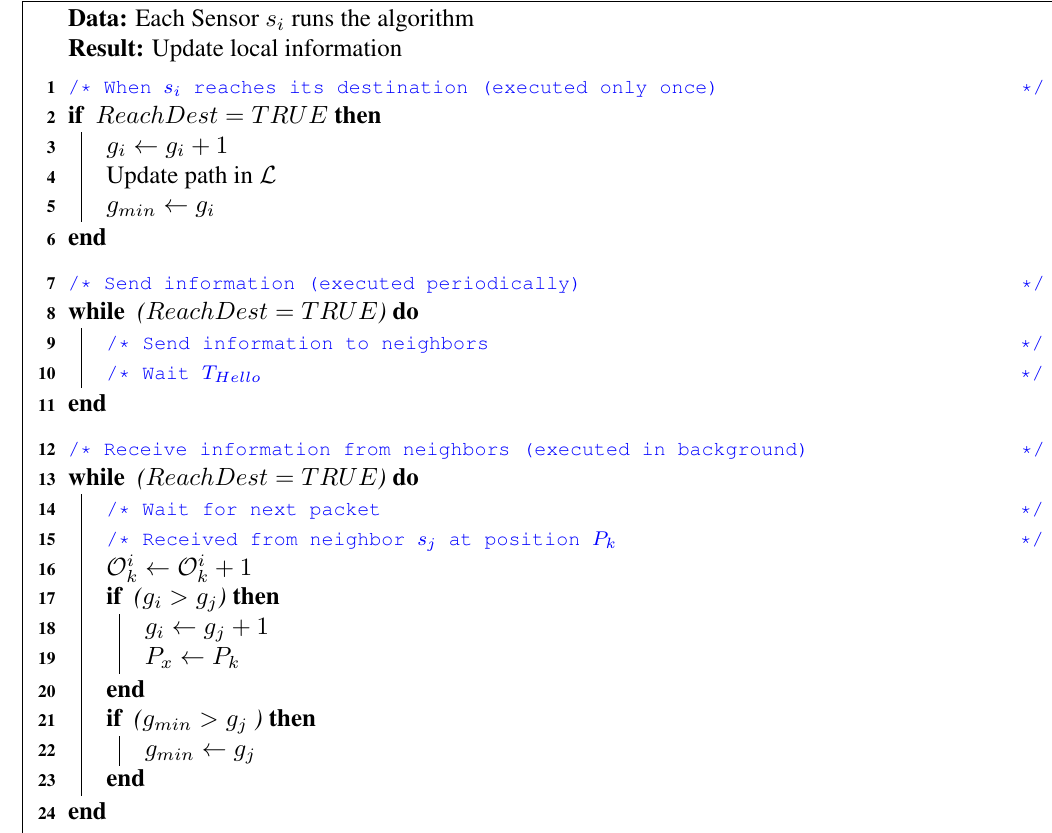
ALGORITHM 2: Updating local